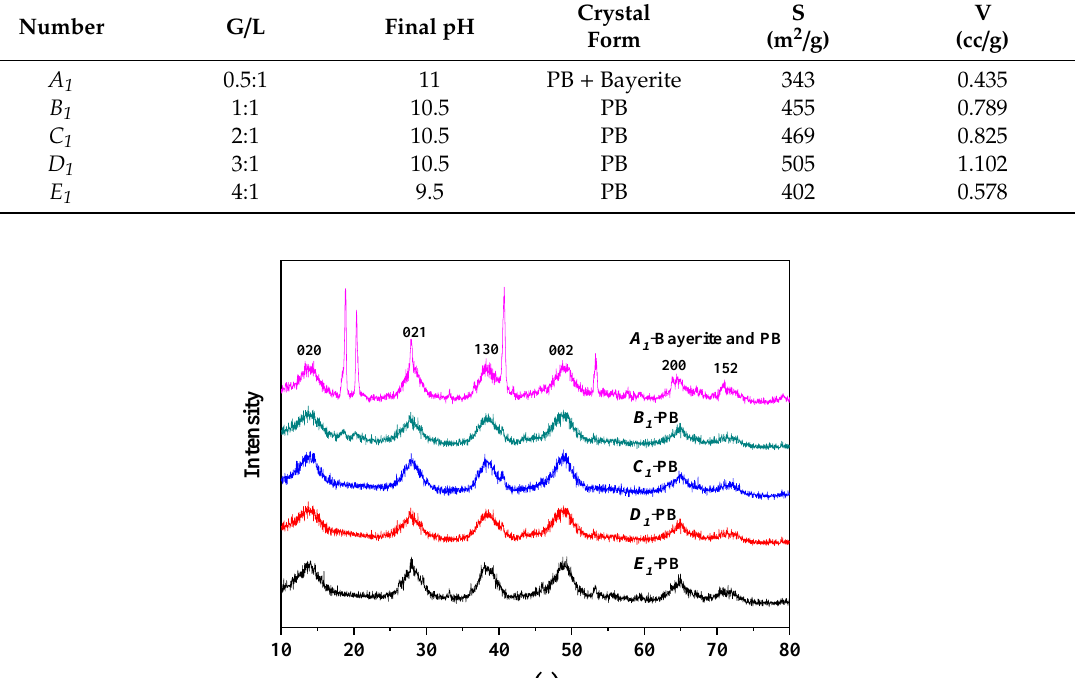
Table 3. The pore properties of PB under different gas – liquid ratios (concentration of NaAlO 2 ,0.1 mol/L; rotating speed of CF-RPB, 600 rpm).